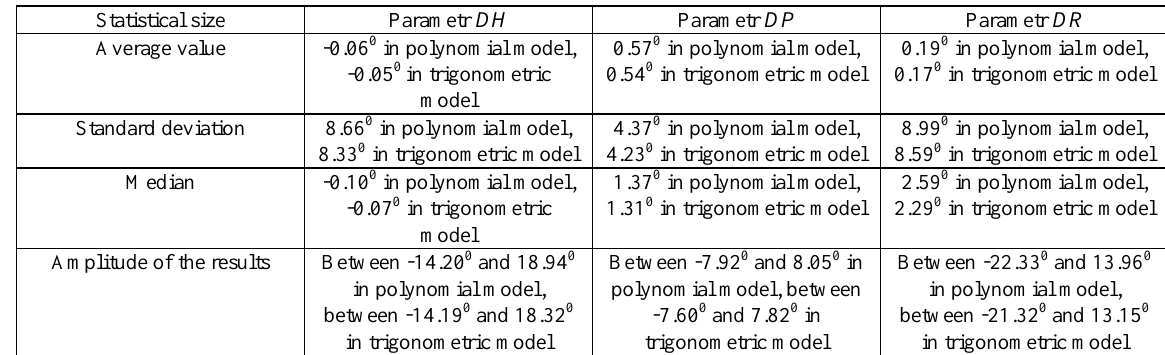
Table 2. The statistical analysis of DH, DP, DR